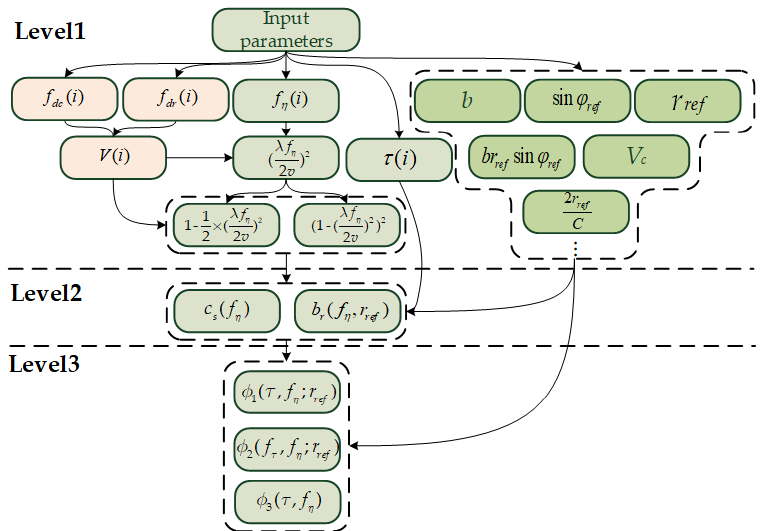
Figure 2. Hierarchical decomposition mapping flow.